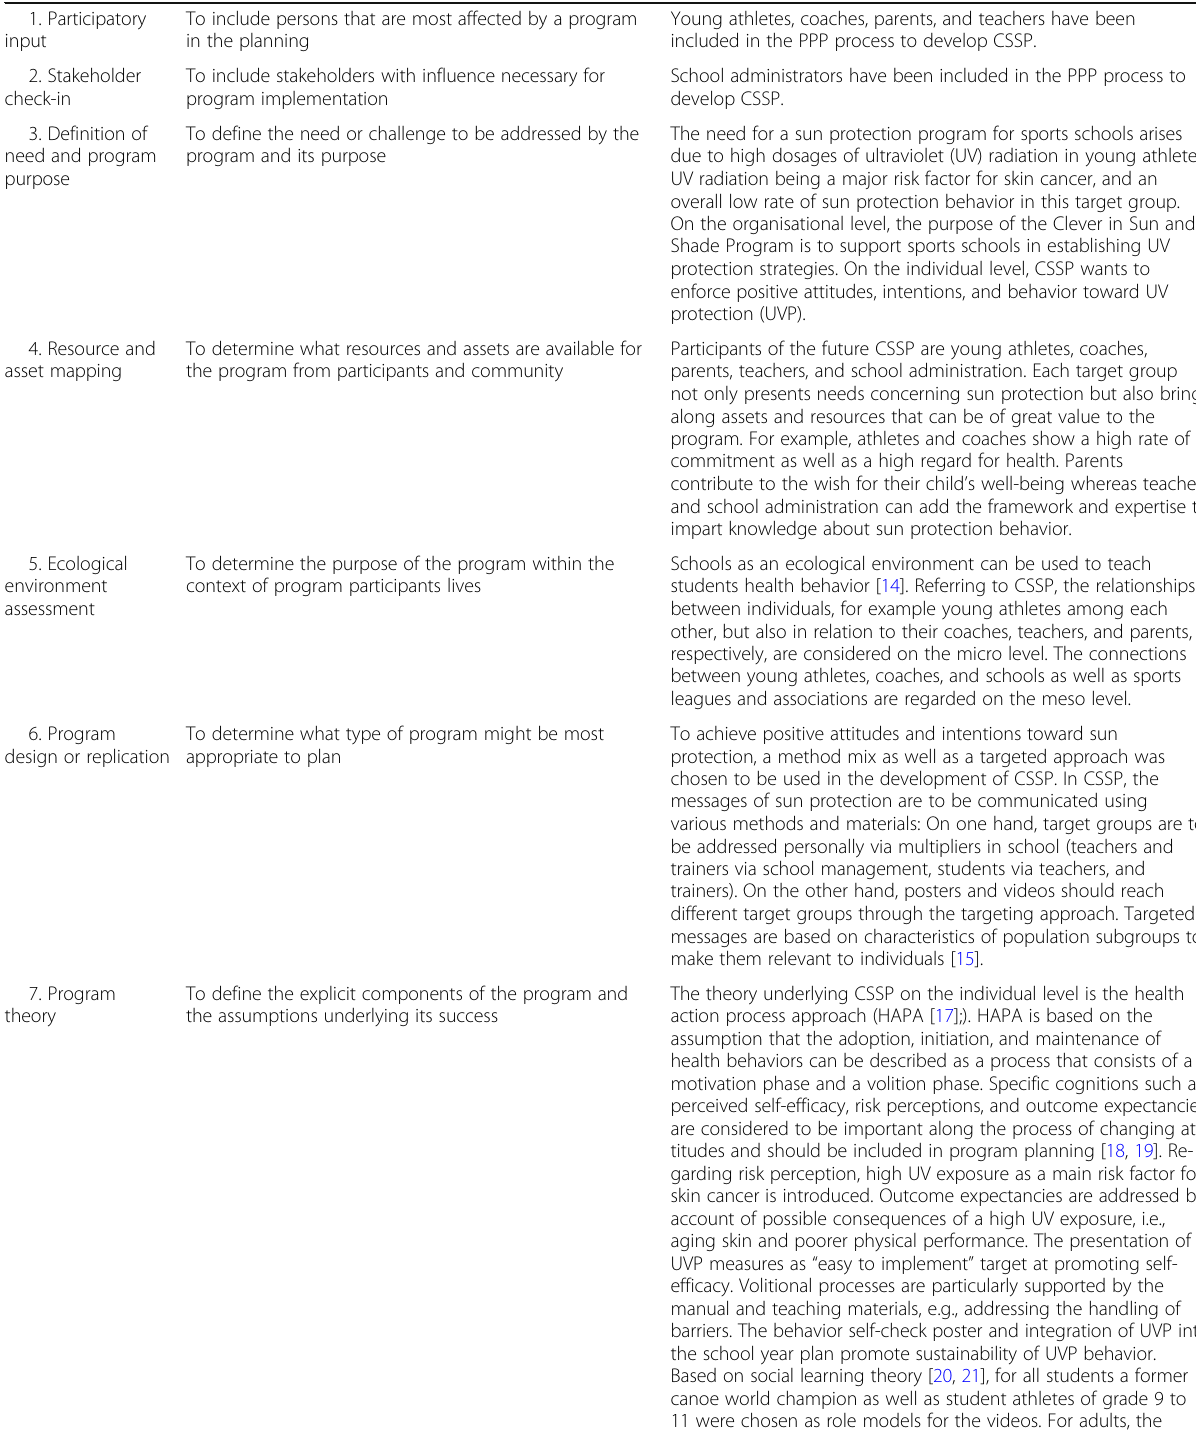
Table 1 Program planning components and their application in the Clever in Sun and Shade Program (CSSP)